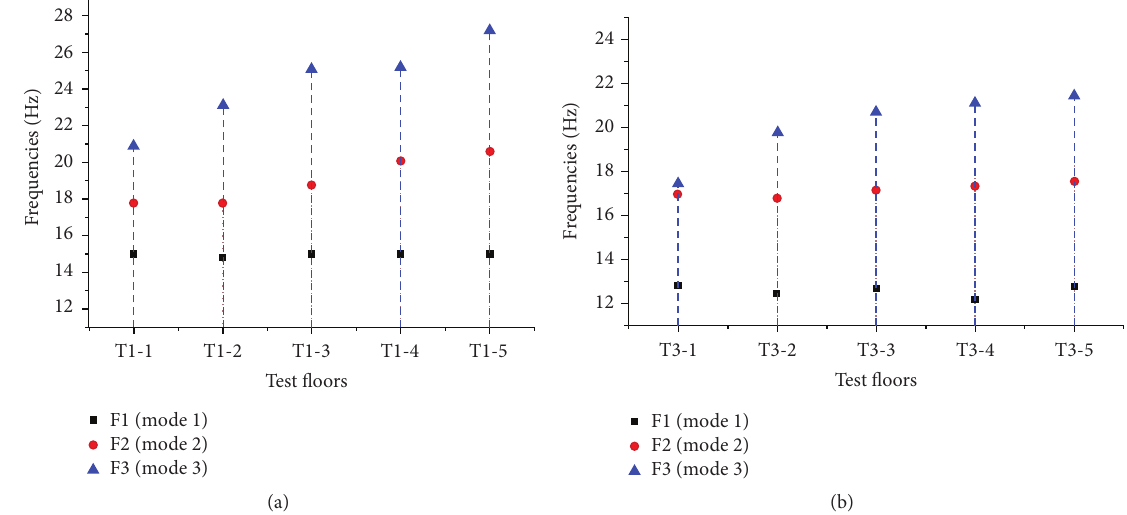
Figure 7: First three natural frequencies of the test floors with the joist spacings of 400mm and 600mm before and after the installation of